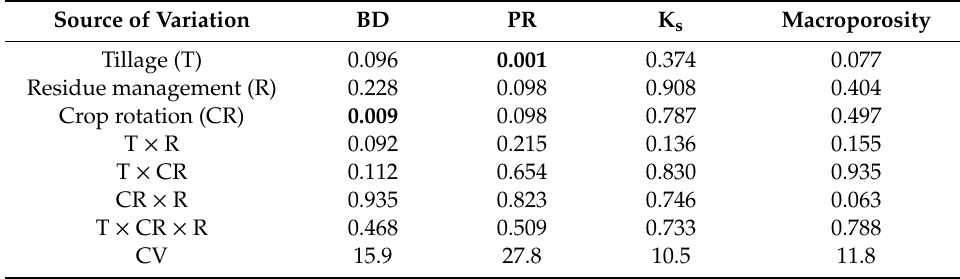
Table 3. p -values of three-way ANOVAs evaluating the e ff ect of tillage (T), residue management (R) and crop rotation (CR) on bulk density (BD), soil resistance (PR), hydraulic conductivity (Ks) and macroporosity after 3 years of cropping in Haplic Cambisol in Alice, Eastern